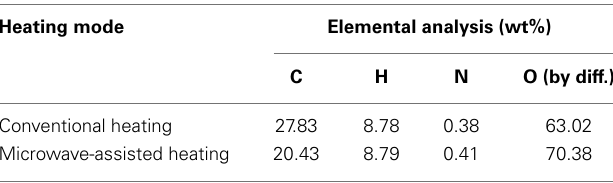
Table 4 | Elemental analyses of bio-oil from bagasse pyrolysis under different heating modes